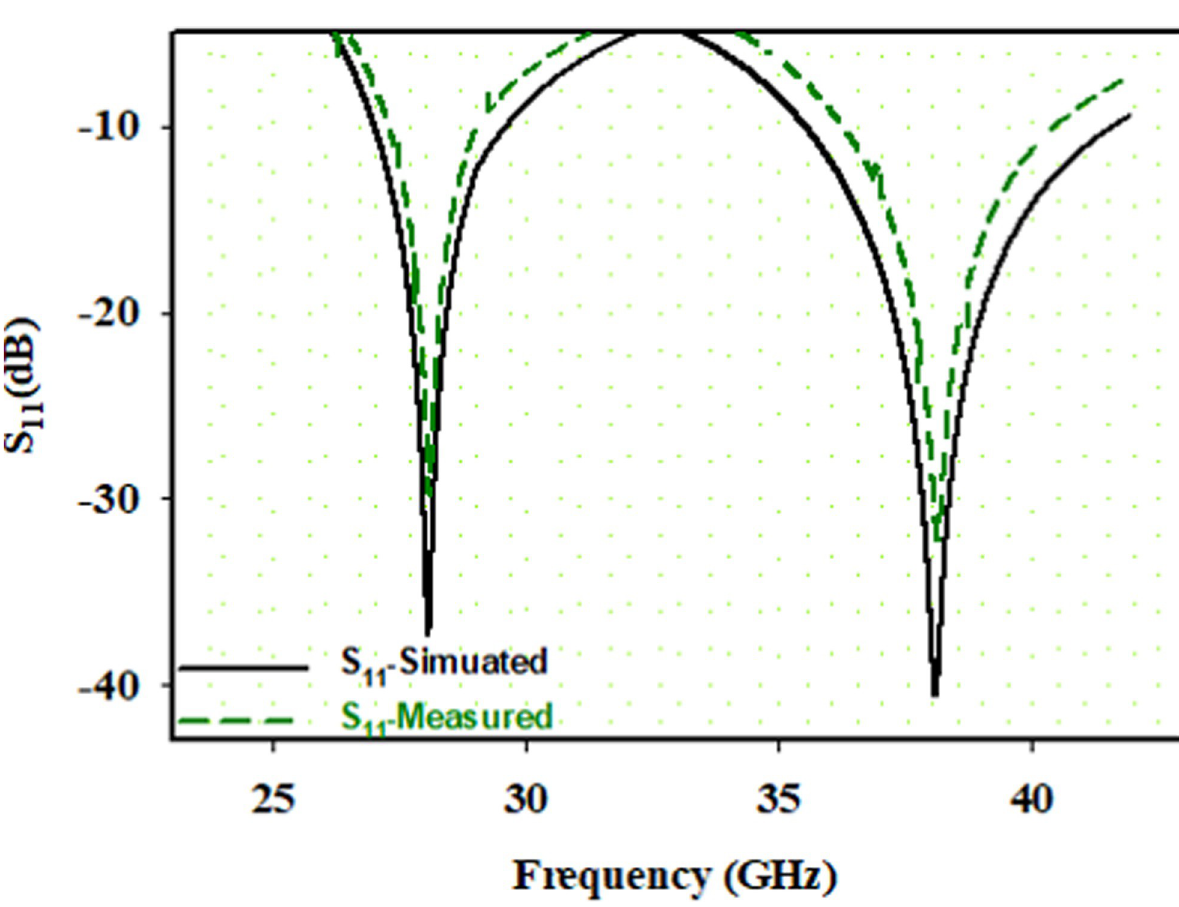
Fig 4. Return loss. S11 result when both S1 and S2 are at ON position. In this section different modes of case 2 and case 3 have been discussed. A single-feed micro- strip patch can radiate circular polarization (CP) if two orthogonal patches modes TM10 and TM01 are simultaneously excited with equal amplitude ± 90˚ out of phase with the sign deter- mining the sense of rotation. This can be accomplished by perturbing the patches at appropri- ate locations to the feed. In the proposed design corner Triango-Truncated perturbation is used to get CP, because there is only one parameter to deal with i.e., the depth of truncation y . The position of the feed for the perturbation plays an important role in determining the sense of rotation (RHCP/LHCP). For LHCP, the truncations are made on orthogonal corners. With perturbation, the fundamental mode is split into two orthogonal modes TM10 and TM01 with slightly different frequencies fda and fdb (Eq 14).